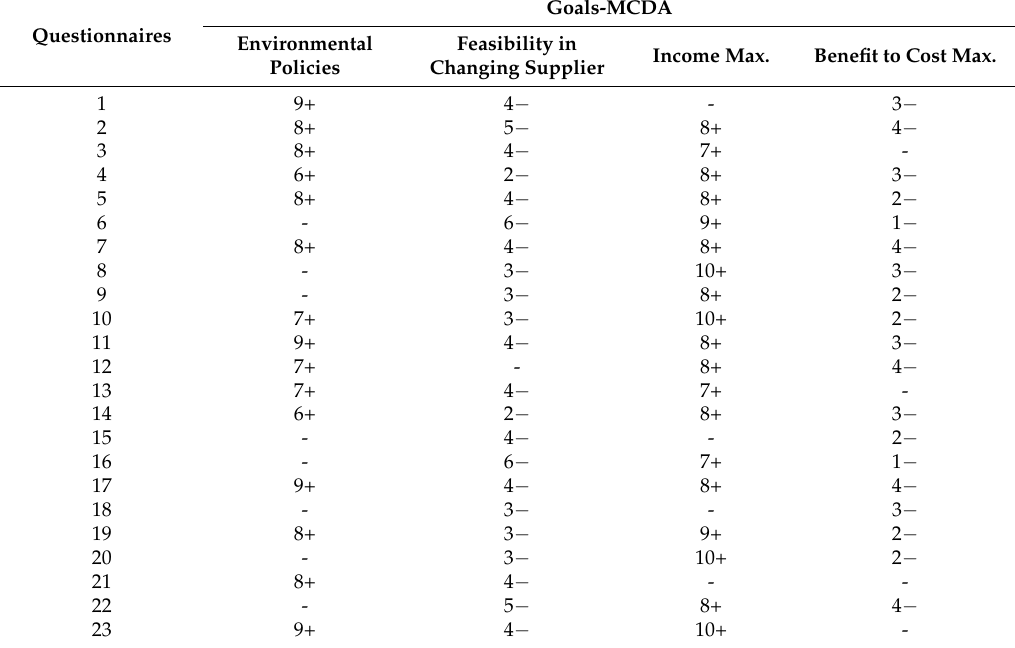
Table A4. Consistency check of the experts’ answers, multiple-criteria decision analysis—interquartile range calculation (last line), empty cells (-) define no answers